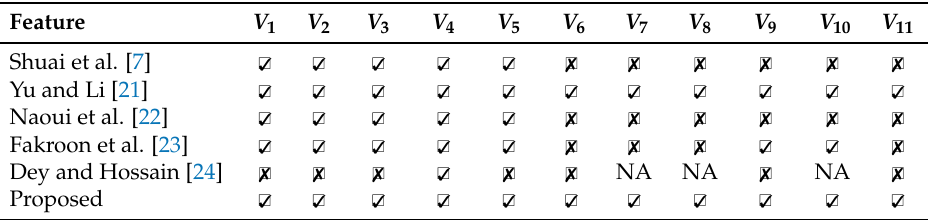
Table 3. Security & functionality features comparison.